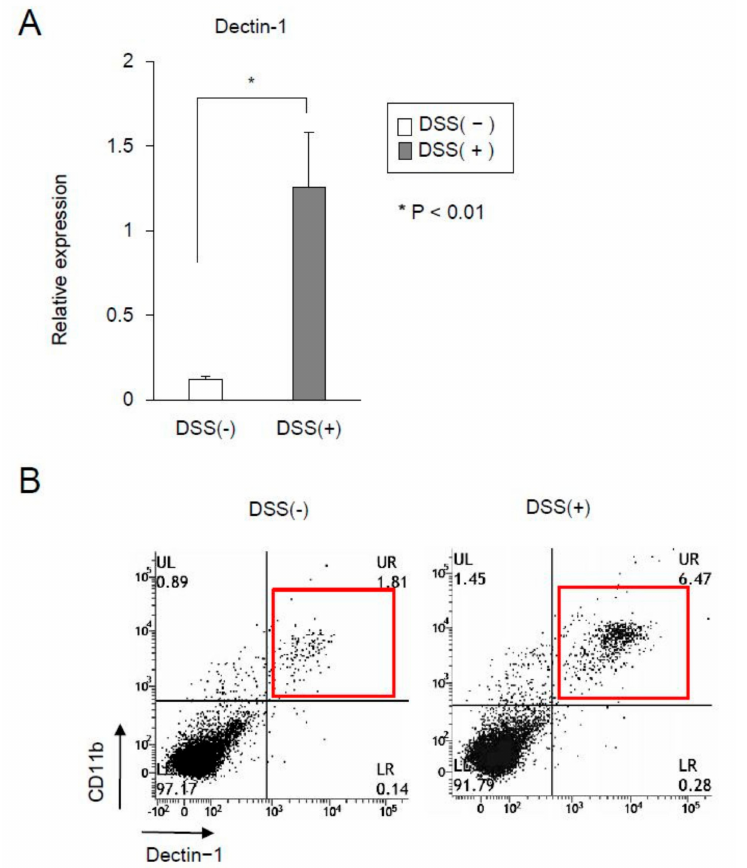
Figure 3. The expression of dectin-1 in the receptor of schizophyllan increased in dextran sodium sulfate-induced acute colitis. ( A ) Dectin-1 mRNA expression in the colon was evaluated using real-time polymerase chain reaction. Data were normalized to the expression of glyceraldehyde-3-phosphate dehydrogenase (GAPDH) mRNA. ( B ) Dectin-1 and CD11b expressions in the lamina propria were analyzed via fluorescence activated cell sorter (FACS) analysis. Data were presented as the mean of the three independent